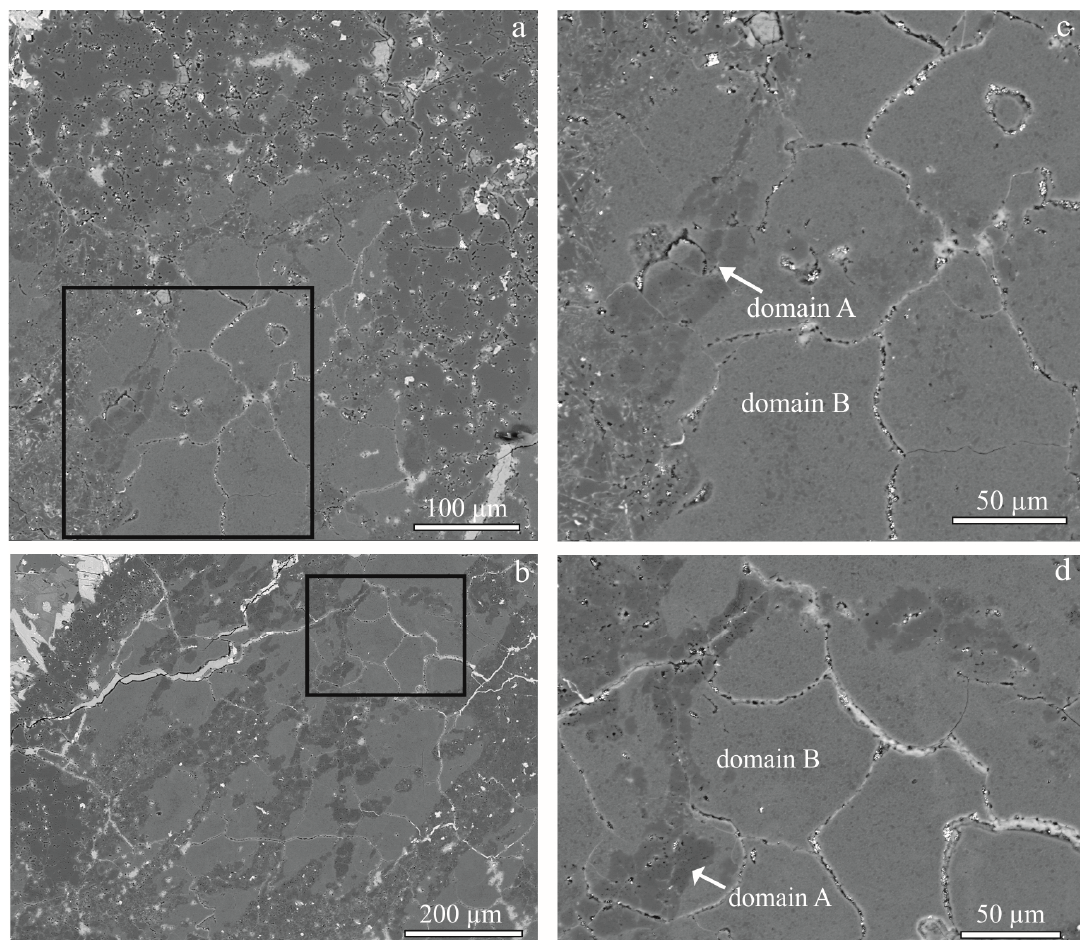
Figure 3. BSE images of ballen quartz obtained in thin section of sample (Jl-05) of impact melt rock from the Jänisjärvi impact structure. Black rectangles in ( a ) and ( b ) show positions of panels ( c ) and ( d ), respectively.